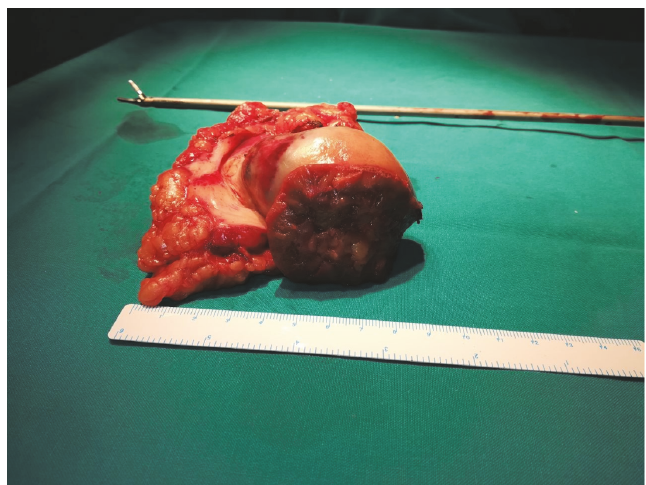
Figure 3: Postoperative photo demonstrating the surgical specimen of the left laparoscopic PN.